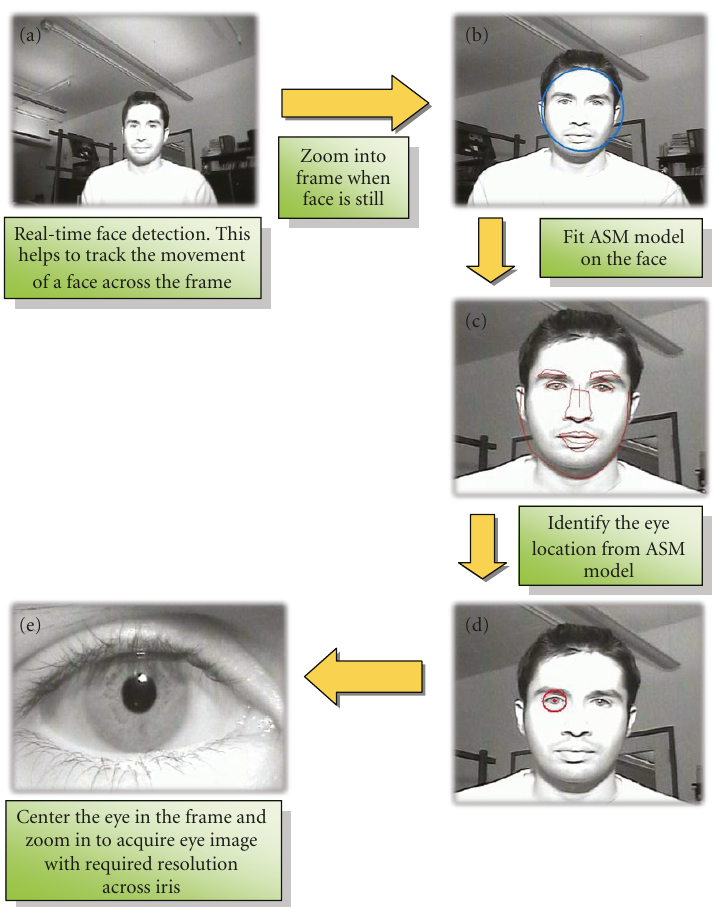
Figure 8: The figure illustrates the entire process of iris acquisition using the COTS PTZ camera. (a)The camera detects any face within the frame and moves (pans/tilts) along with it, keeping the face at the center. (b) Once it is sure that the face is still (i.e., the person stops moving), it zooms into the face (c) and fits the Active Shape Model (ASM) model on the face. (d) The position of the eye of interest is read o ff from the ASM output and (e) the camera zooms into the frame keeping this eye at the center (by pan/tilt).